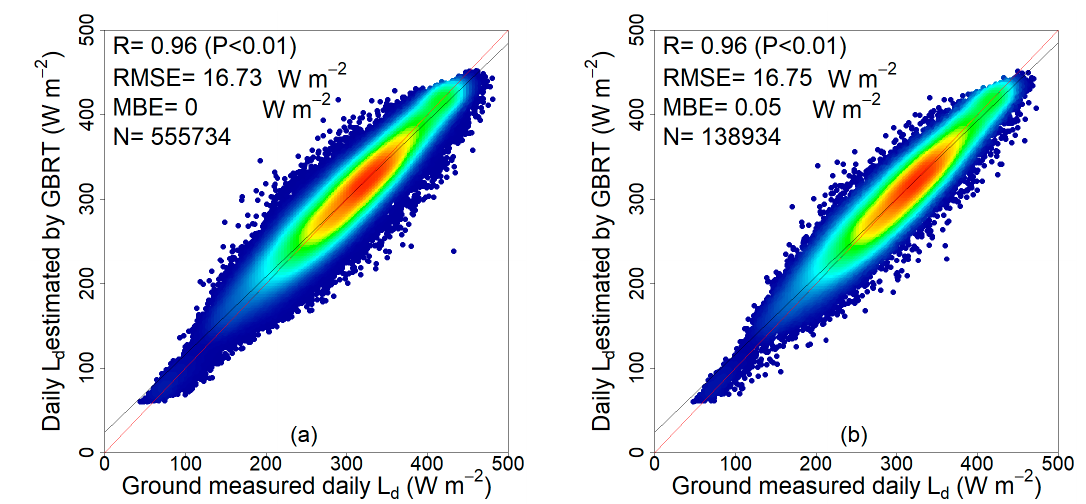
Figure 3. Evaluation results of daily L d estimates on the basis of the GBRT model for ( a ) the training dataset and ( b ) the test dataset against the ground measurements from March 2000 to December 2018.